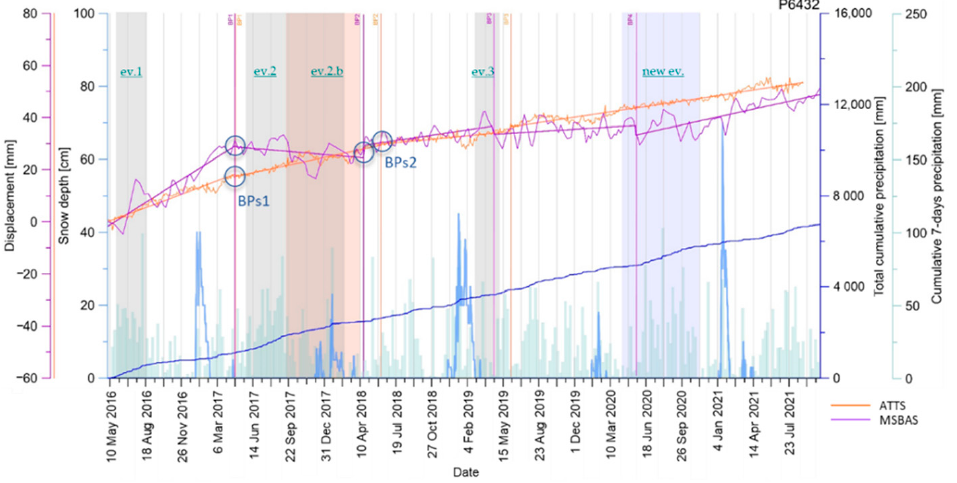
Figure 10. Horizontal (EW) displacement time series correlation of ATTS (red) against MSBAS (purple) for the intersection zone. Evaluation of Trends and BPs of point n. P6432 plotted against total cumulative precipitation (dark blue line), cumulative 7-days precipitation (histogram), and snow depth (light blue line).